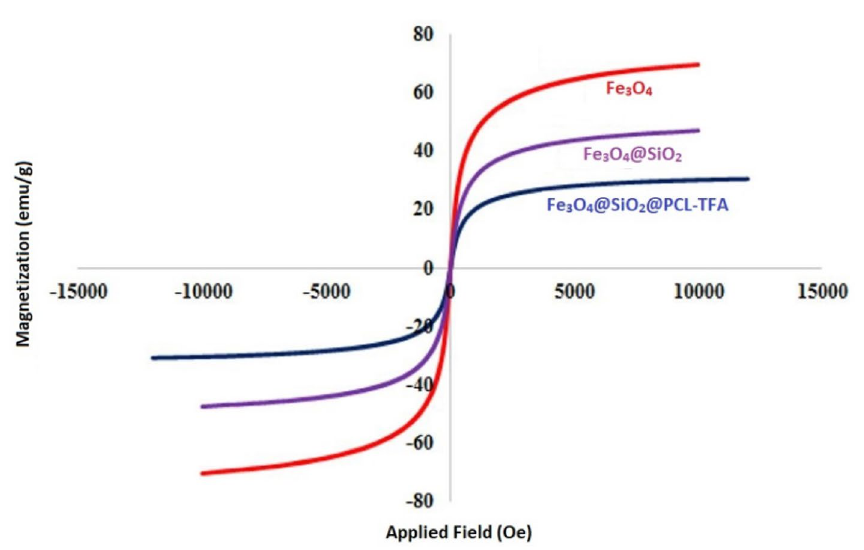
Figure 7. VSM curves of Fe 3 O 4 @SiO 2 @PCLH-TFA in comparison with its related magnetic